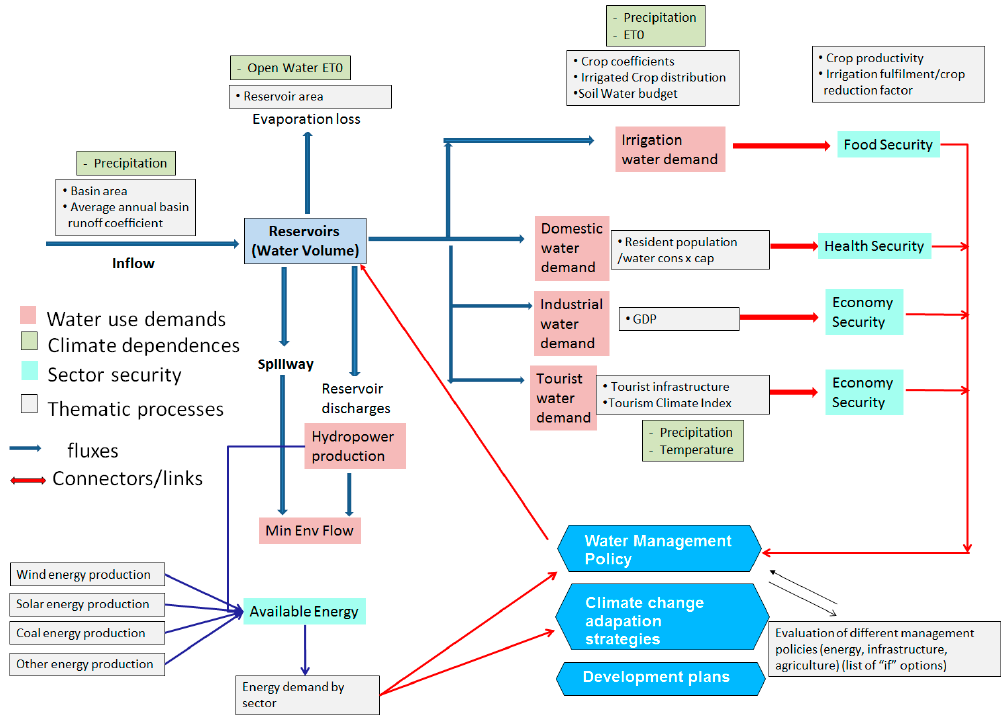
Figure 3. Conceptual diagram describing the major nexus components relevant for the Sardinia case study. ETO is reference evapotranspiration.